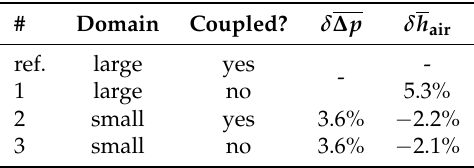
Table 2. Validation of the uncoupled simulations.